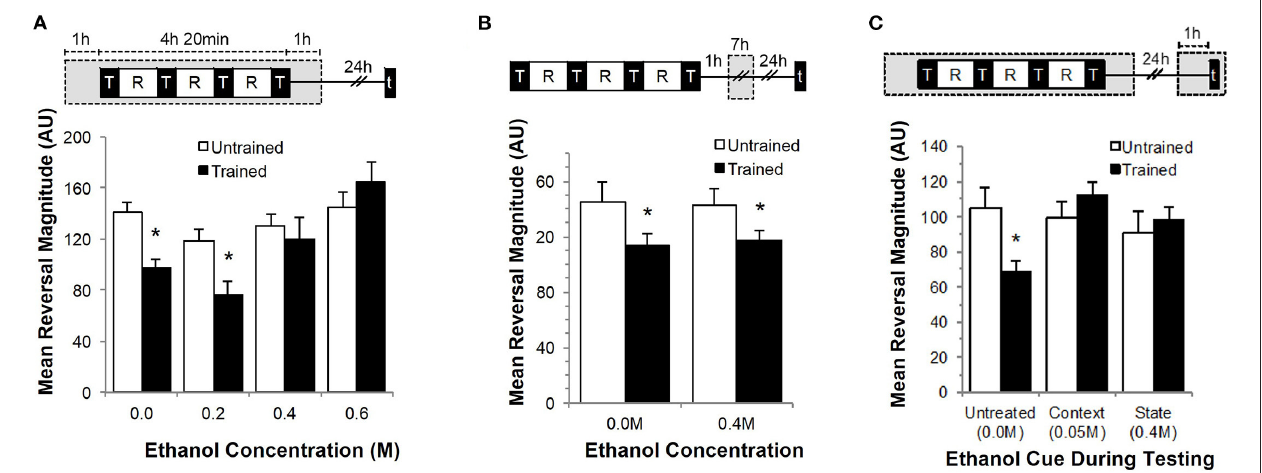
FIGURE 1 | Effects of ethanol exposure during training on long-term memory for habituation. Each graph includes an illustration of corresponding training and ethanol exposure protocols where gray boxes indicate time of ethanol exposure while black boxes indicate training periods denoted by “T” and test periods denoted by “t.” White squares indicate rest periods denoted by “R.” (A) Mean reversal response magnitude ( ± SEM) measured at testing 24h after exposure to 0.0, 0.2, 0.4 or 0.6M ethanol exposure compared between trained (black bars) and untrained groups (white bars). (B) Mean reversal response magnitude ( ± SEM) compared between trained (black bars) and untrained groups (white bars) with 7-h ethanol exposure delivered 1-h after training completed. (C) Mean reversal response magnitude ( ± SEM) measured after 0.4M ethanol exposure during training and re-exposed to either 0.05M (context cue) or 0.4M (internal state cue) at testing compared to an unexposed conditioned group. * = p <